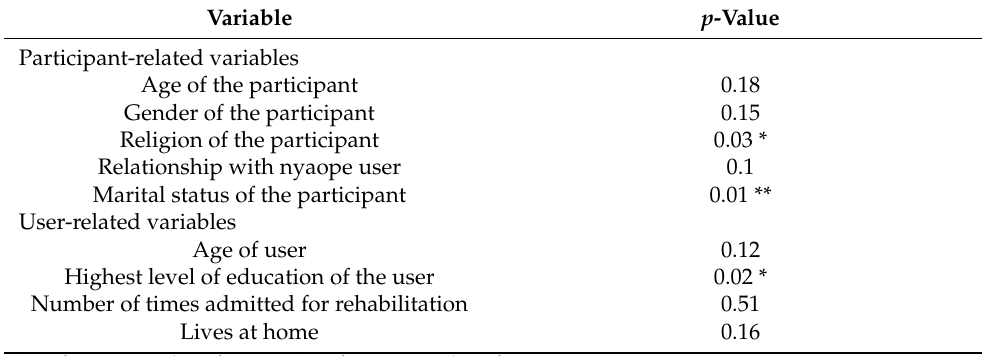
Table 6. Results of multiple regression of the socio-demographics and depressive symptoms. Variable p -Value Participant-related variables Age of the participant 0.18 Gender of the participant 0.15 Religion of the participant 0.03 *